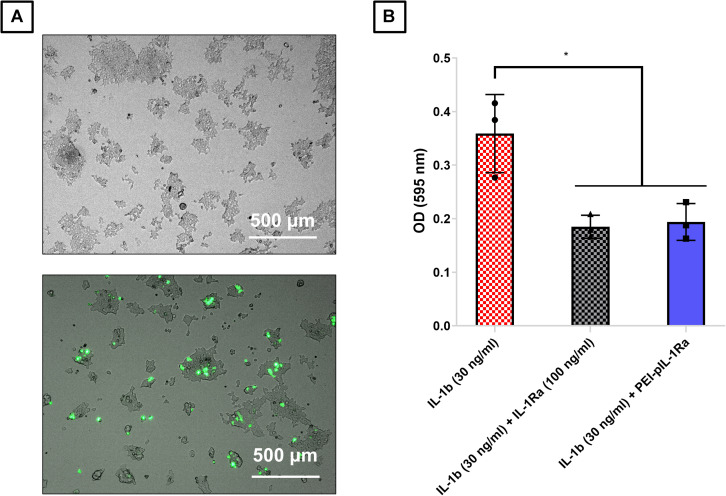
Assessment of PEI-pIL-1Ra nanoparticle gene product bioactivity. (A) Representative brightfield and fluorescence microscopy image overlay depicting non-transfected (top) and successfully transfected HEK-Blue IL-1β cells with PEI-pIL-1Ra nanoparticles (bottom). (B) Quantification of secreted enzymatic alkaline phosphatase activity in cells transfected with PEI-pIL-1Ra nanoparticles, in response to treatment with IL-1β (30 ng/ml), in comparison to non-transfected cells treated with IL-1β (30 ng/ml), and IL-1β (30 ng/ml) + IL-1Ra (100 ng/ml). * denotes p < 0.05. Data plotted represents mean ± standard deviation, n = 3.